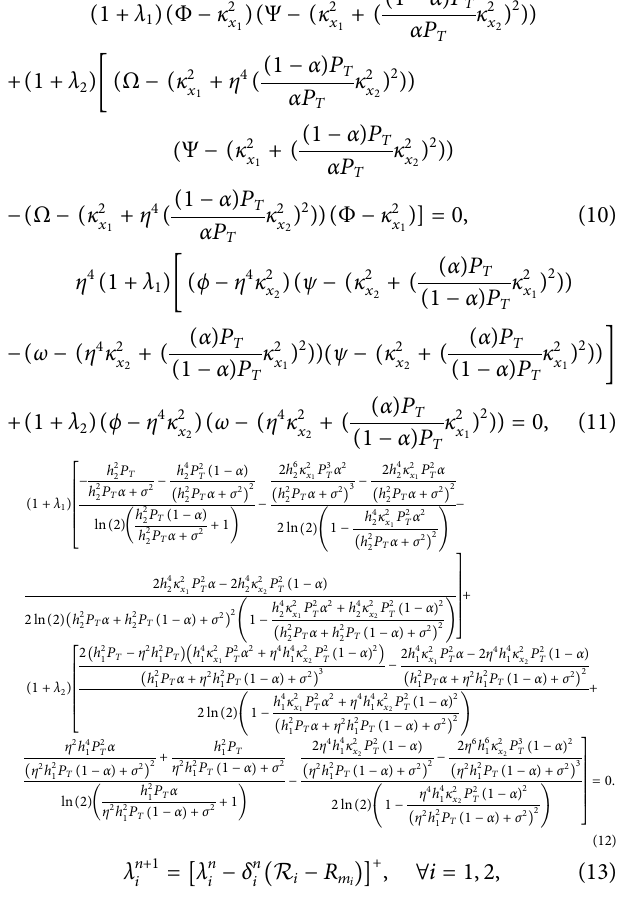
Algorithm 1. : Spectral ef fi ciency maximization